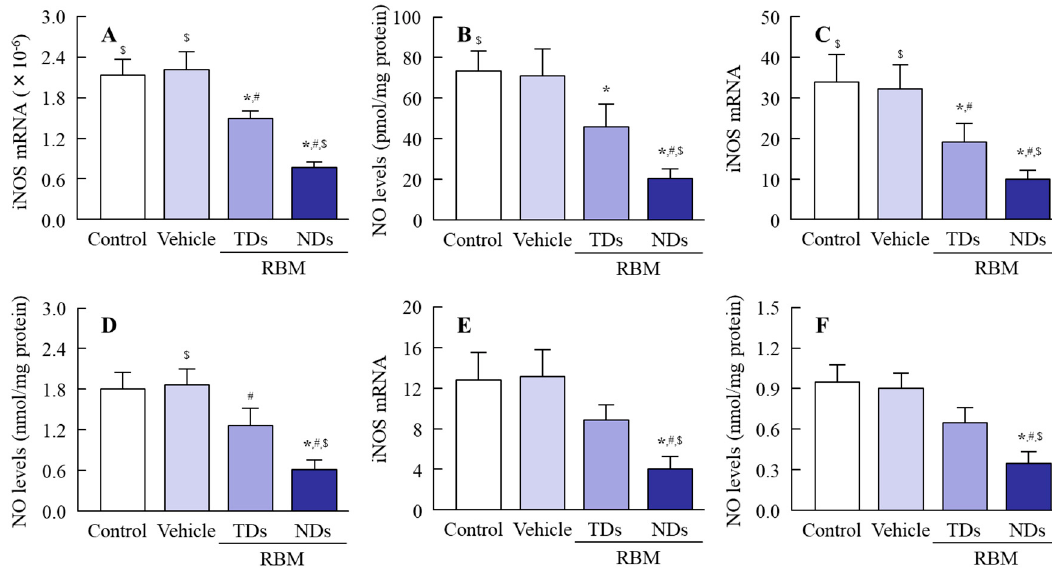
Figure 7. Preventive effect of RBM-NDs on increased levels of inducible nitric oxide synthase (iNOS) mRNA and nitric oxide (NO) in the gastric, jejunal, and ileal mucosa of IMC-stimulated AA rats. ( A , C , E ) iNOS mRNA in the gastric ( A ), jejunal ( C ), and ileal ( E ) mucosa in AA rats treated with vehicle, RBM-TDs, and RBM-NDs. ( B , D , F ) NO levels in the gastric ( B ), jejunal ( D ), and ileal ( F ) mucosa in AA rats treated with vehicle, RBM-TDs, and RBM-NDs. Control: IMC-stimulated AA rats; vehicle: IMC-stimulated AA rats treated with vehicle; RBM-TDs: IMC-stimulated AA rats treated with RBM-TDs; RBM-N: IMC-stimulated AA rats treated with RBM-NDs. n = 4–9, * p > 0.05 vs. control, # p > 0.05 vs. vehicle, $ p > 0.05 vs. RBM-TDs. RBM attenuated the overexpression of iNOS mRNA and NO, and the preventive effects were greater for RBM-NDs than RBM-TDs.